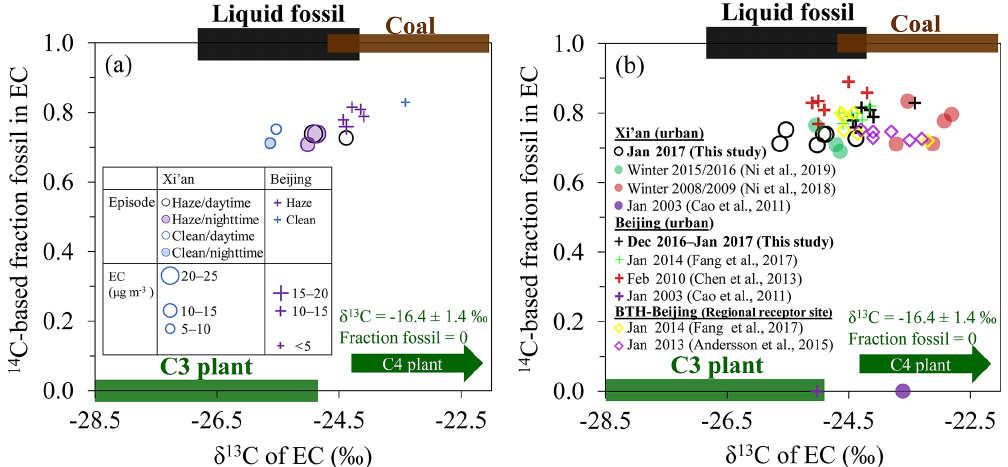
Figure 3. (a) The 14 C-based fraction fossil vs. δ 13 C for EC during haze and clean periods in Xi’an and Beijing, China. The symbol size is an indicator of EC concentrations. (b) Comparison with previous observations in Xi’an and Beijing, in which BTH-Beijing is a regional receptor site of Beijing located 100km southwest of Beijing. Samples from Cao et al. (2011) are placed on the x axis because no 14 C data were available. The expected 14 C and δ 13 C endmember ranges for emissions from C 3 plant burning, liquid fossil fuel burning, and coal burning are shown as green, black, and brown bars, respectively. The δ 13 C source signatures are indicated as mean plus or minus the standard deviation (SD) (Sect. 2.4). The δ 13 C signature of corn stalk burning (i.e., C 4 plant; − 16.4 ± 1.4‰) is also